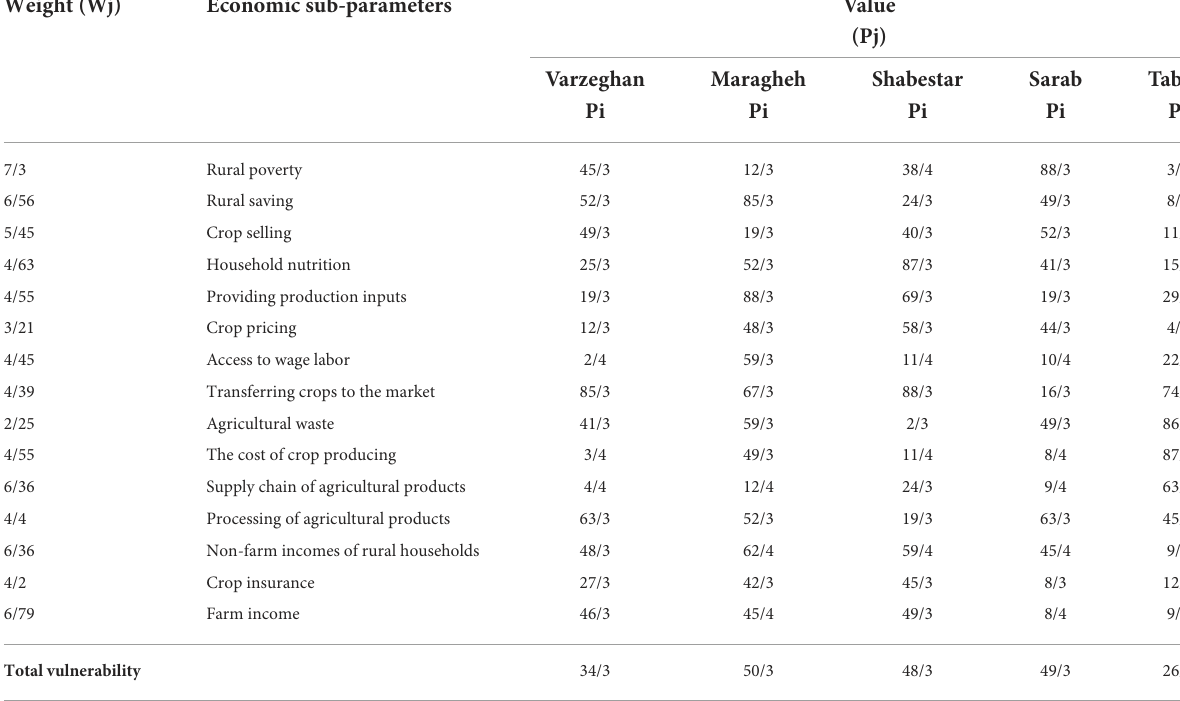
TABLE 2 The values and weights of farmers’ economic vulnerability parameters. Weight